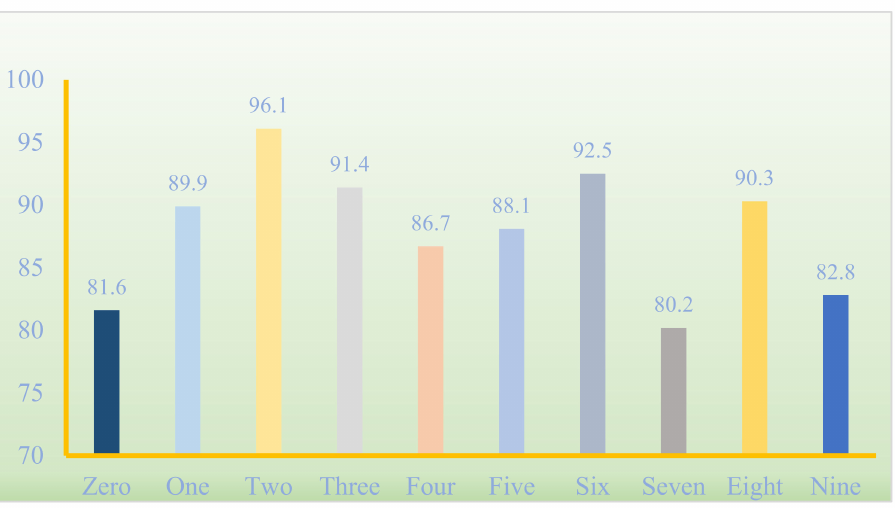
Figure 13. Recall statistics of the English independent